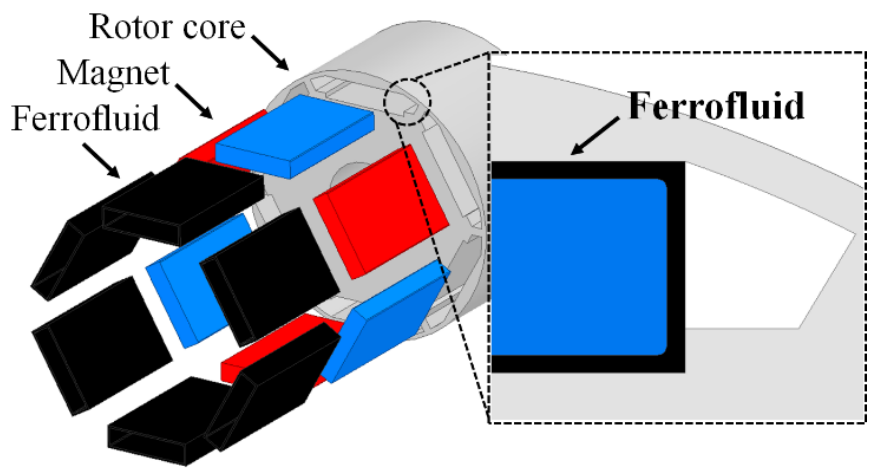
Figure 6. Rotor of the conventional model with ferrofluid.